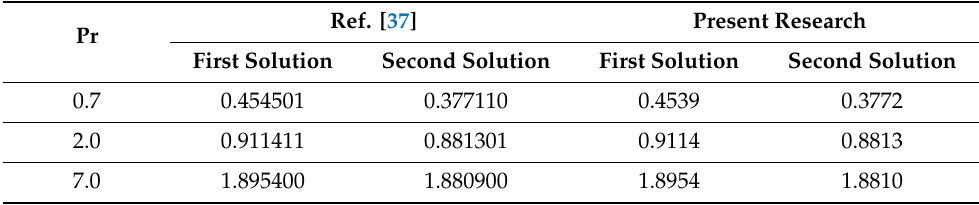
Table 3. Comparison of the values of − θ (cid:48) ( 0 ) when We = S = R d = 0, m = 1, γ = ∞ .